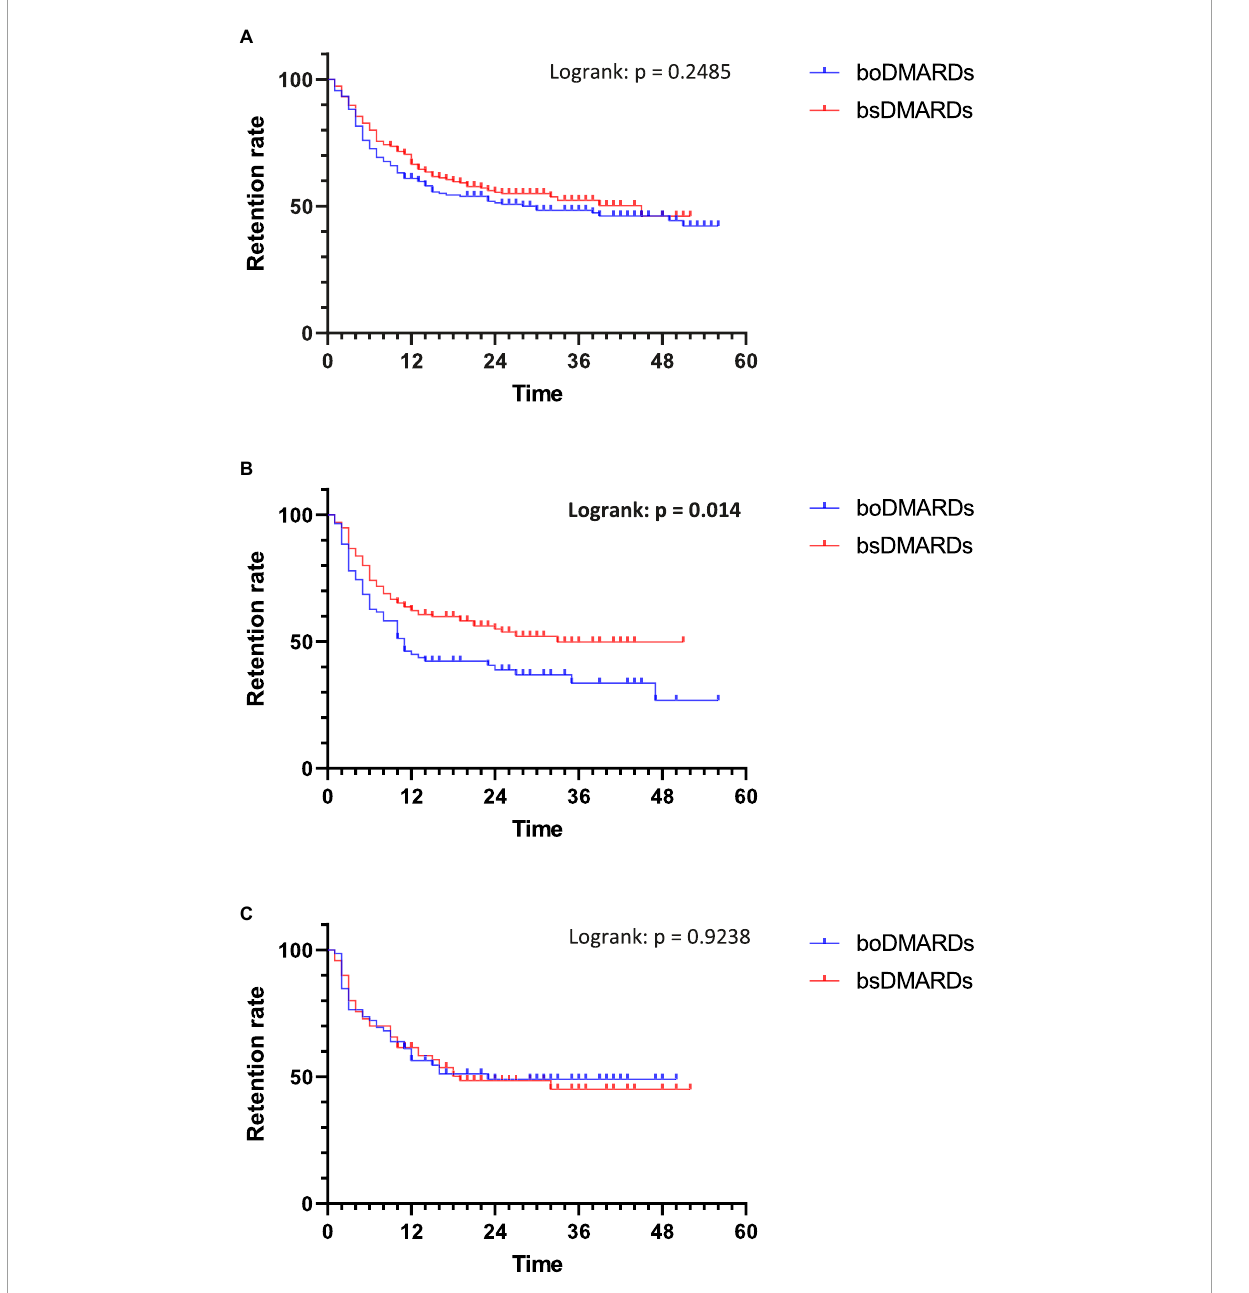
FIGURE5 Retention of treatments depending on the line of treatments. (A) First line of treatment; (B) Second line of treatment; (C) Third line of treatment.